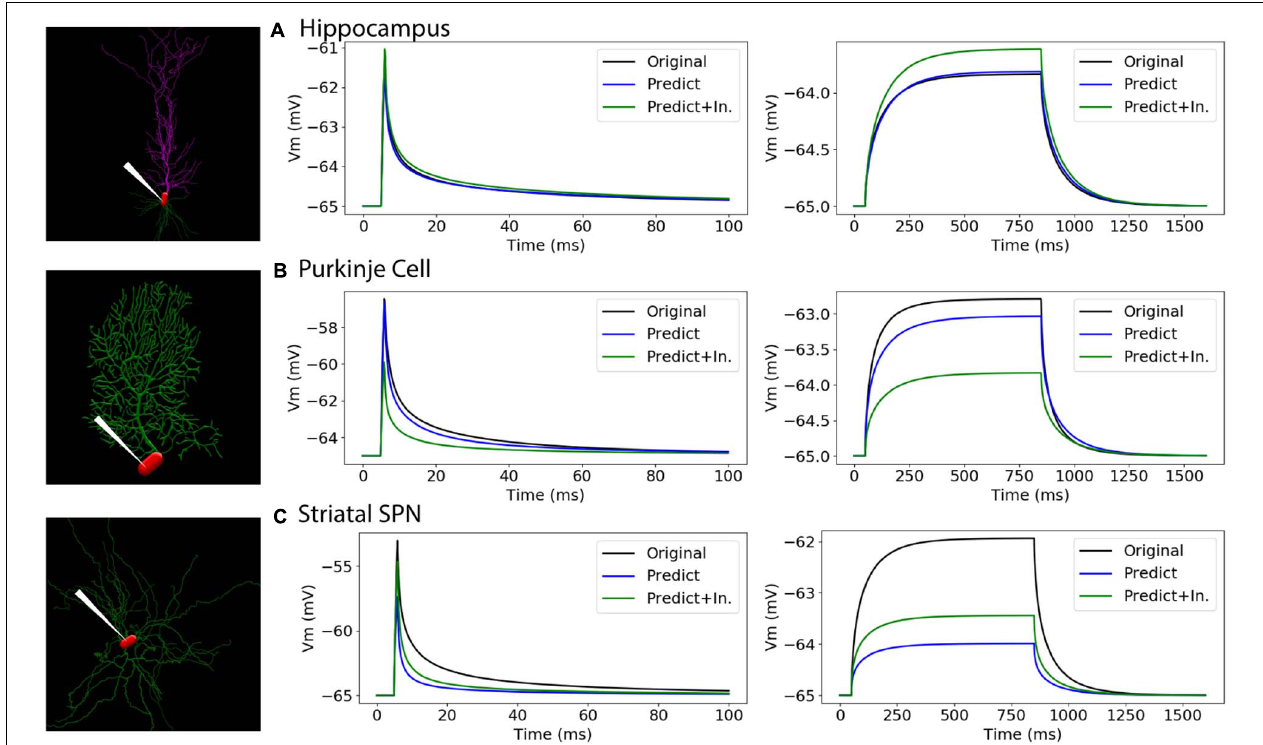
FIGURE 9 | Passive response is similar when predicted diameters are correlated with original diameters. (A–C) Simulation strategy, with location of current injection and voltage recording at the soma compartment (left panel); 1 ms (center) and 800 ms (right) current injection. (A) Hippocampal CA1 pyramidal cell (NMO_35137), with apical and basal dendrites. (B) Cerebellar Purkinje cell (NMO_10073). (C) Striatal SPN (NMO_33253). Normalized difference (ratio) was calculated for both time constants ( τ 1 , τ 2 ) and steady state ( (cid:49) V) to compare modified morphology response to original response. Simulation parameters provided in Methods. Simulation of predictions were quite similar to original morphology for Hippocampal CA1 pyramidal and Cerebellar Purkinje cells, and were not improved by using original initial diameters. Simulation of predictions with original initial diameters improved passive response for the striatal